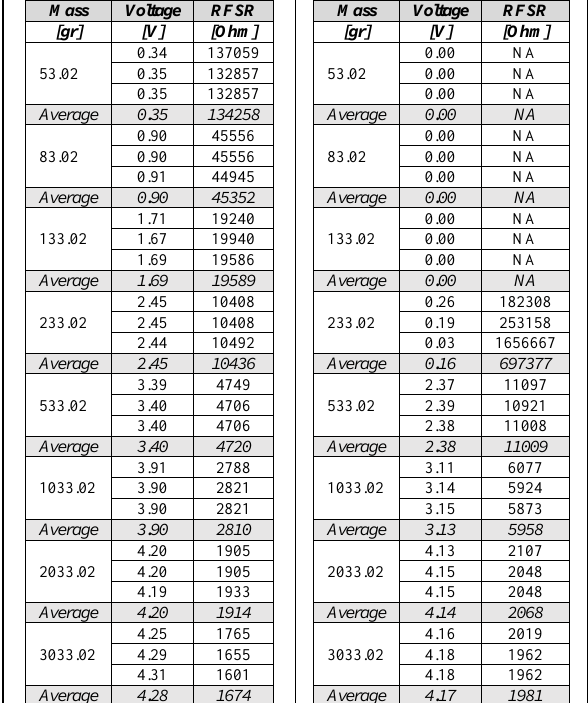
Table 7. Response of the sensor vs. the applied loads on Deep3R6 and Deep3R8 sensor housing with silicone layer (left and right panels, respectively).